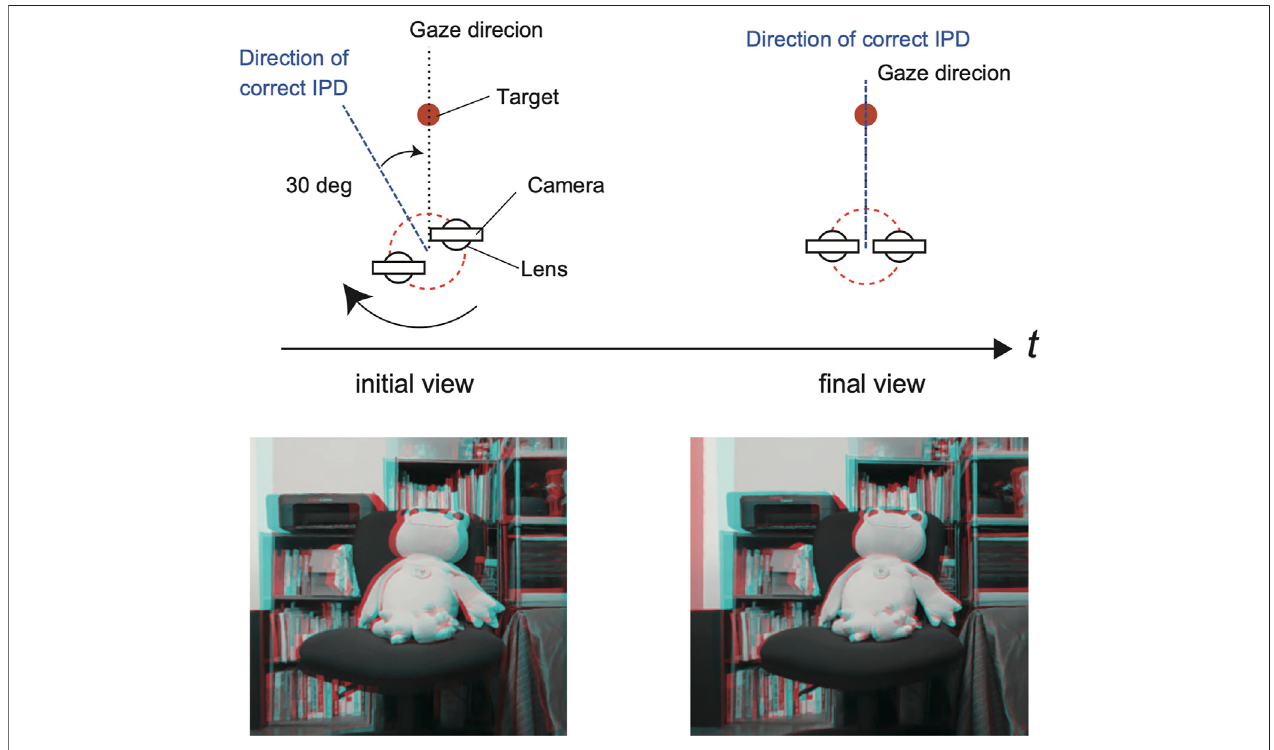
FIGURE11| Stereoscopicvisualstimuliforexperiment3.Intheinitialview,thedirectionofthegazetothetargetandthedirectionofcorrectbinoculardisparitywere notaligned.Afterarotationintheyawdirection,thetwodirectionswerealignedsothattheobservercouldseethescenewiththecorrectIPD.Therotationalvelocitywas varied as 15, 30, 50, and 75 ° /s. The bottom images show screenshots in the gaze direction of the initial and fi nal views converted into gray anaglyphic stereo.